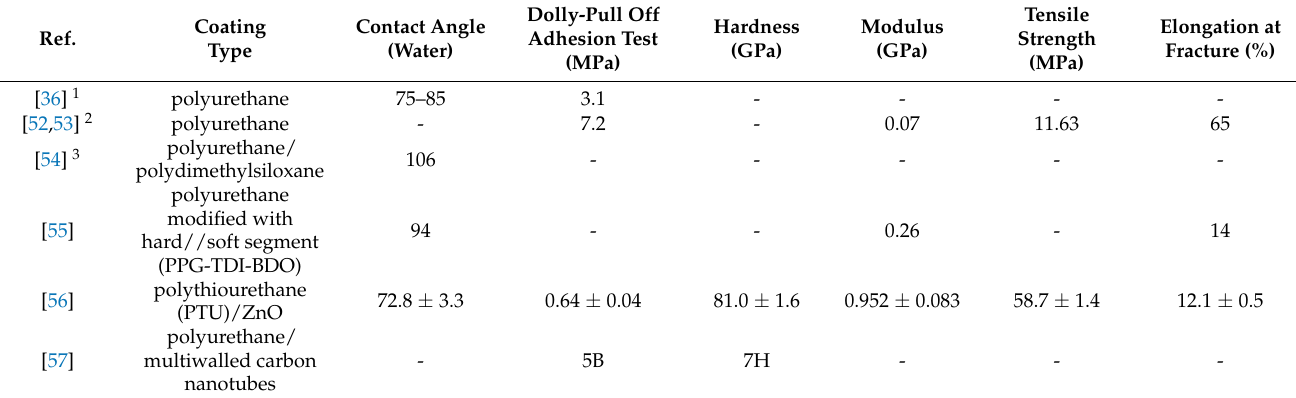
Table 3. Contact angle and mechanical characterization of polyurethane-based coatings.